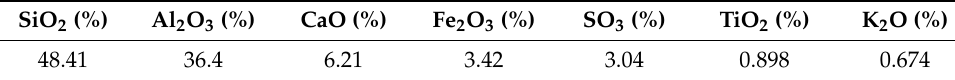
Table 3. Chemical composition of